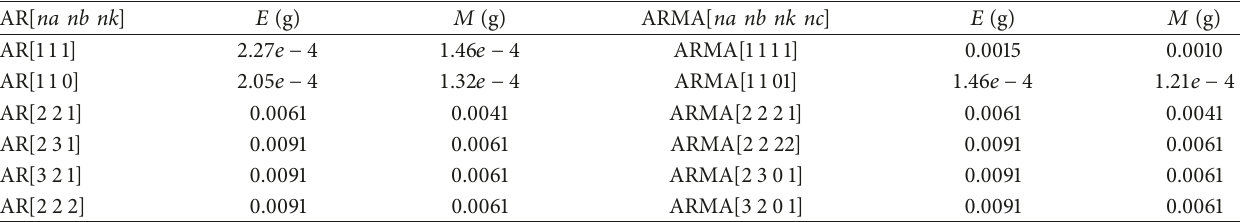
Table 3: Statistical parameters analysis for the models’